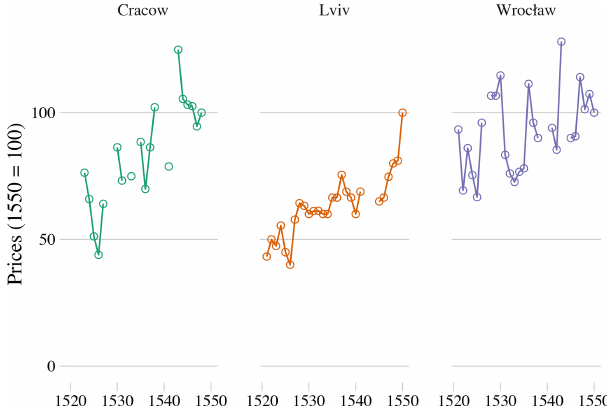
Figure 15. Grain exports from Gda´nsk. Source: Samsonowicz (1956), Kutrzeba and Duda